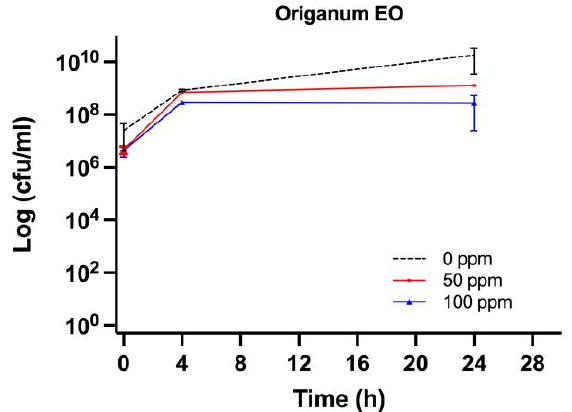
Figure 2. E. coli cell load in Brain Heart Infusion medium and plated on MacConkey agar (Log CFU/mL): OEO (0, 50, and 100 ppm).